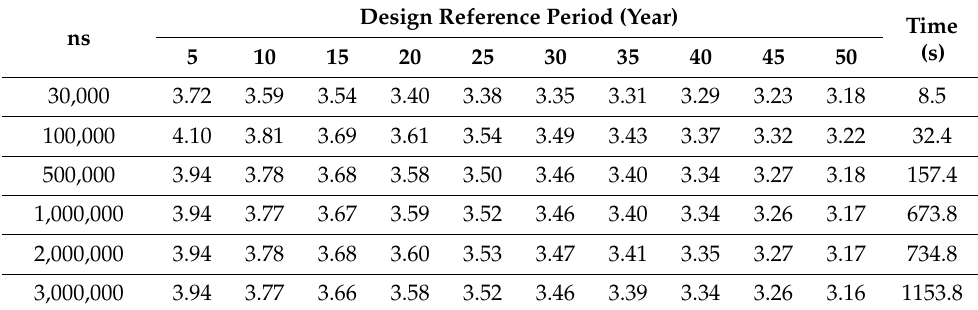
Figure 5. Reliability index curves of reinforced concrete short column of a structure in design reference period. Table 4. Calculation results of Monte Carlo method under different sample numbers.